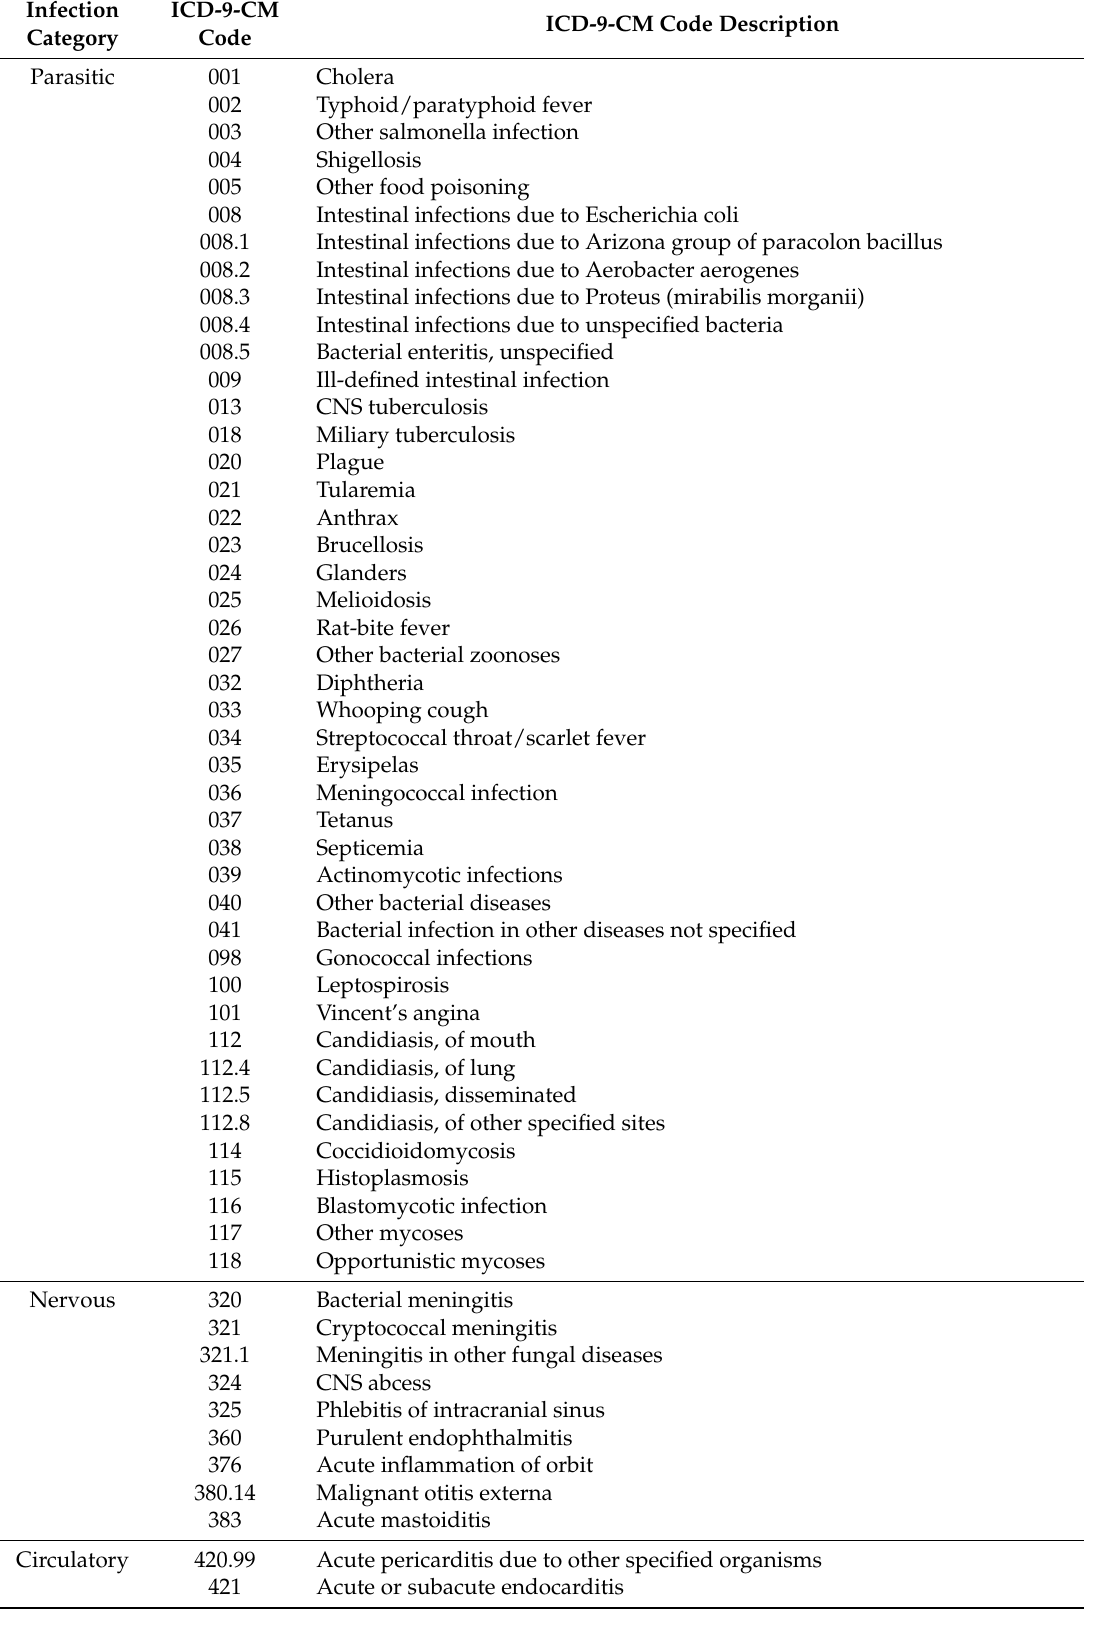
Table A2. Angus, et al. ICD-9 codes for serious infection